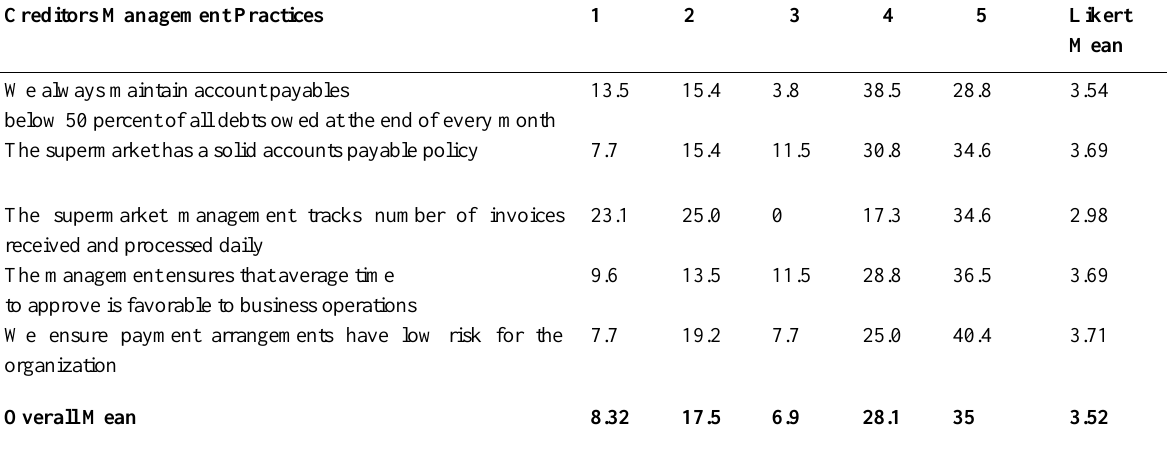
Table 2: Analysis of Creditors Management Practices and Operational